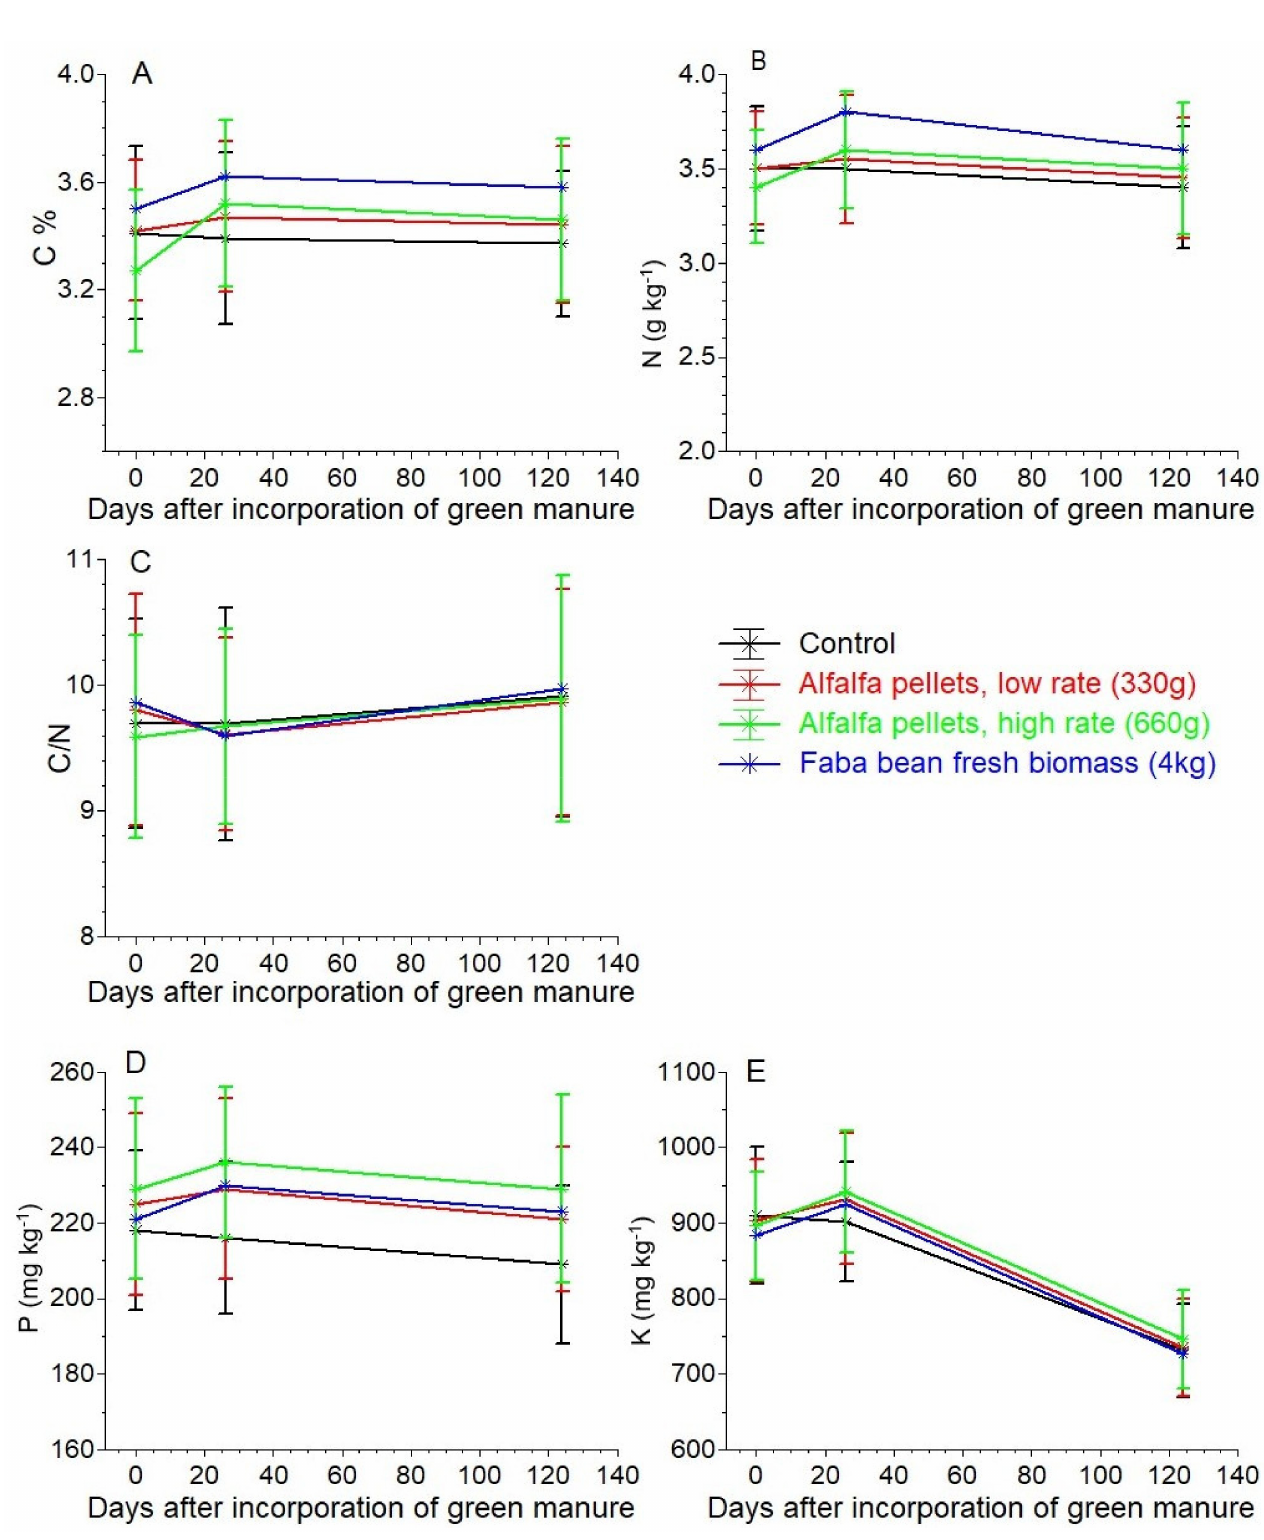
Figure 1. Organic C ( A ), total-N ( B ), C/N ratio ( C ), available P ( D ) and K ( E ), in dried soil before legume biomass incorpora- tion (D 0), after tomato transplanting (D 26) and at tomato crop termination (D 124). The vertical bars represent ± standard errors of